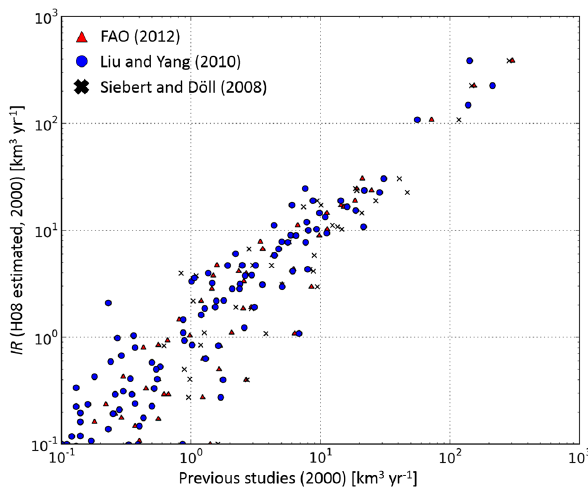
Figure 4. Comparison of IR WFD,2000 (km 3 yr − 1 ) with previous studies (crosses: Siebert and Döll, 2008; circles: Liu and Yang, 2010; triangles: FAO,